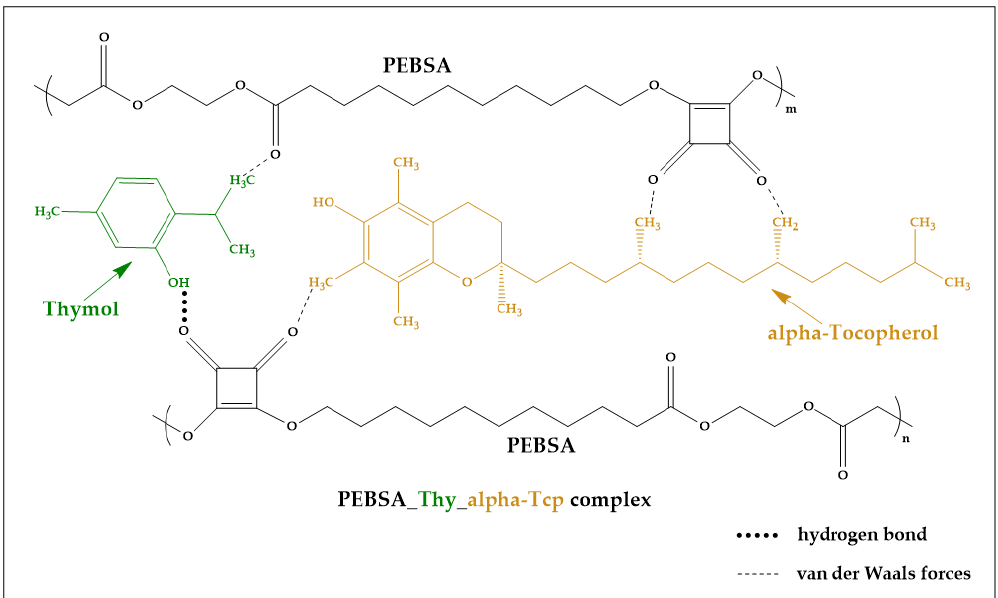
Figure 1. Illustration of PEBSA_Thy_ α -Tcp bioactive complex formation.